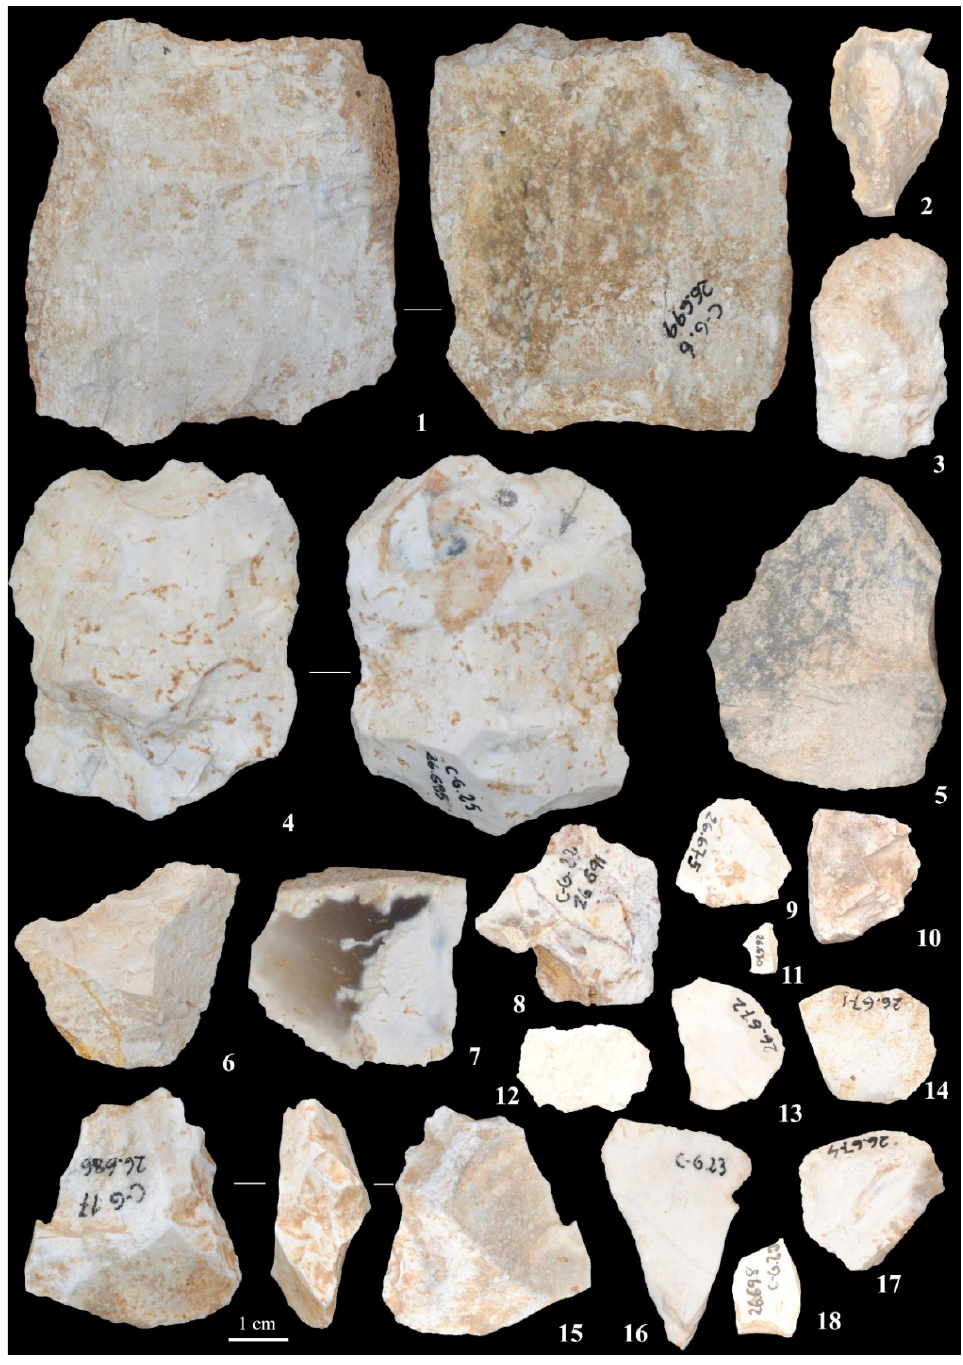
Figure 9. Lithic artifacts from Cova del Gegant. ( 1 ): Levallois core. ( 2 , 6 , 10 , 12 ): Flake fragment. ( 3 , 5 , 7 – 9 , 11 , 13 , 14 , 16 – 18 ): Flake. ( 4 ): Discoid core. ( 15 ).